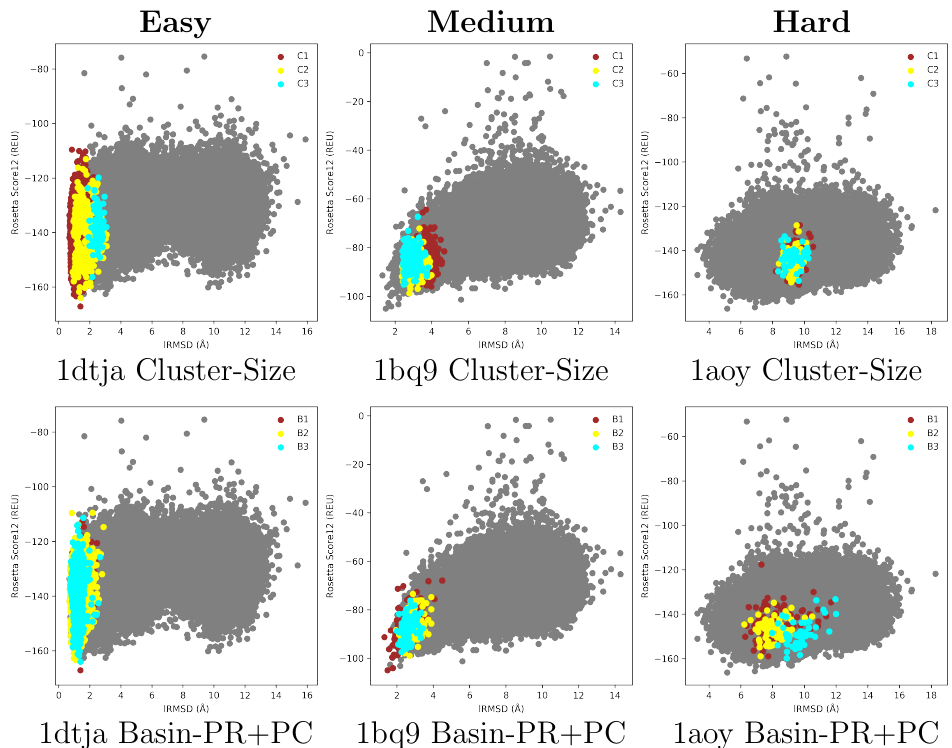
Figure 1. Visualization of selected clusters (first row) and basins (second row) for representative targets with native structures under PDB entries 1dtja, 1bq9, and 1aoy. Decoys are plotted by their least RMSD (after removing rigid-body motions) from the structure in the PDB entry ( x axis) and their Rosetta score12 all-atom energy measured Rosetta Energy Units—REUs ( y